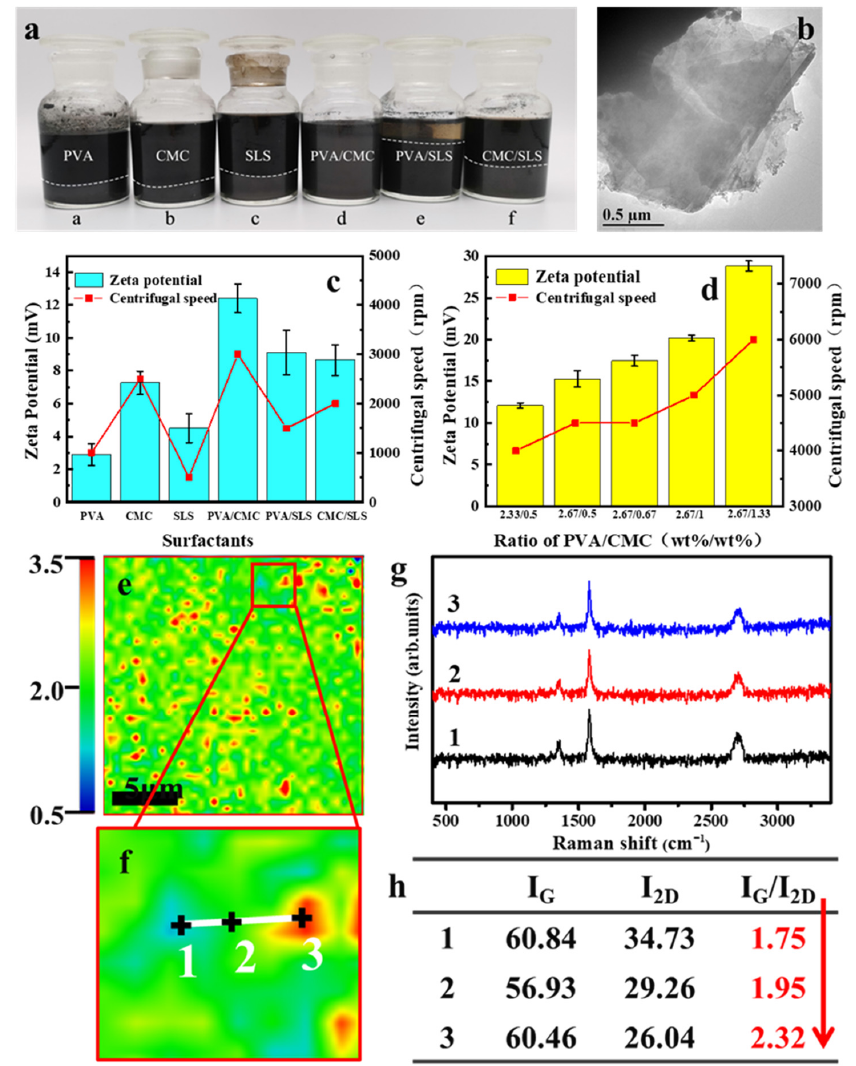
Figure 1. ( a ) Photos of the 5 wt% graphene dispersions with different surfactant including PVA (3 wt%), CMC (3 wt%), SLS (3 wt%), PVA/CMC (1.5 wt%:1.5 wt%), PVA/SLS (1.5 wt%:1.5 wt%) and CMC/SLS (1.5 wt%:1.5 wt%), respectively. The pictures were taken 2 months after sample preparation. ( b ) The TEM image of the graphene dispersion with PVA/CMC (1.5 wt%:1.5 wt%). ( c ) Zeta potential (cyan histogram) and the highest centrifugation speed before precipitation (red line) for the fresh samples in ( a ). ( d ) Zeta potential (yellow histogram) and the highest centrifugation speed before precipitation (red line) for the fresh samples with 5 wt% graphene and different proportions of PVA/CMC which are 2.33 wt%/0.5 wt%, 2.67 wt%/0.5 wt%, 2.67 wt%/0.67 wt%, 2.67 wt%/1 wt%, and 2.67 wt%/1.33 wt%, respectively. ( e ) Raman mapping of the graphene dispersion with PVA/CMC (2.67 wt%:1.33 wt%). ( f ) The enlarged view of the selected part of Figure 1e. ( g ) The Raman spectrums of the three representative sites in Figure 1f. ( h ) Intensity of the corresponding G-band and 2D-band in ( g ) and the I G /I 2D values.